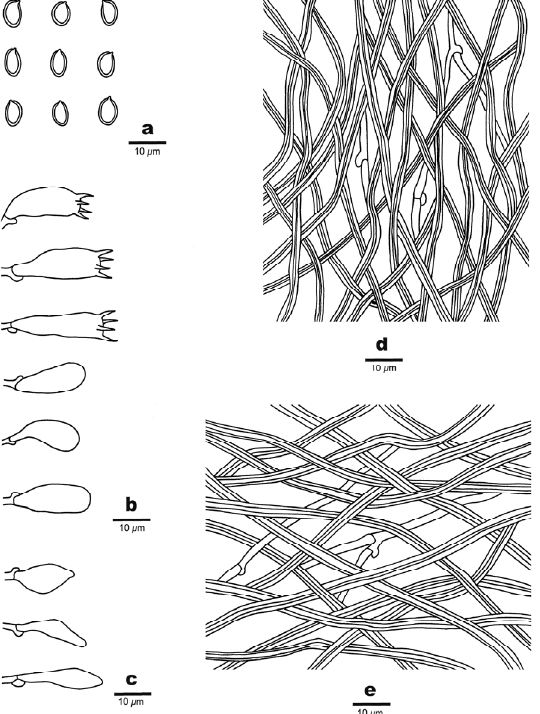
Figure 4. Microscopic structures of Luteoperenniporia australiensis (Holotype). ( a ). Basidiospores. ( b ). Basidia and basidioles. ( c ). Cystidioles. ( d ). Hyphae from trama. ( e ). Hyphae from subiculum.